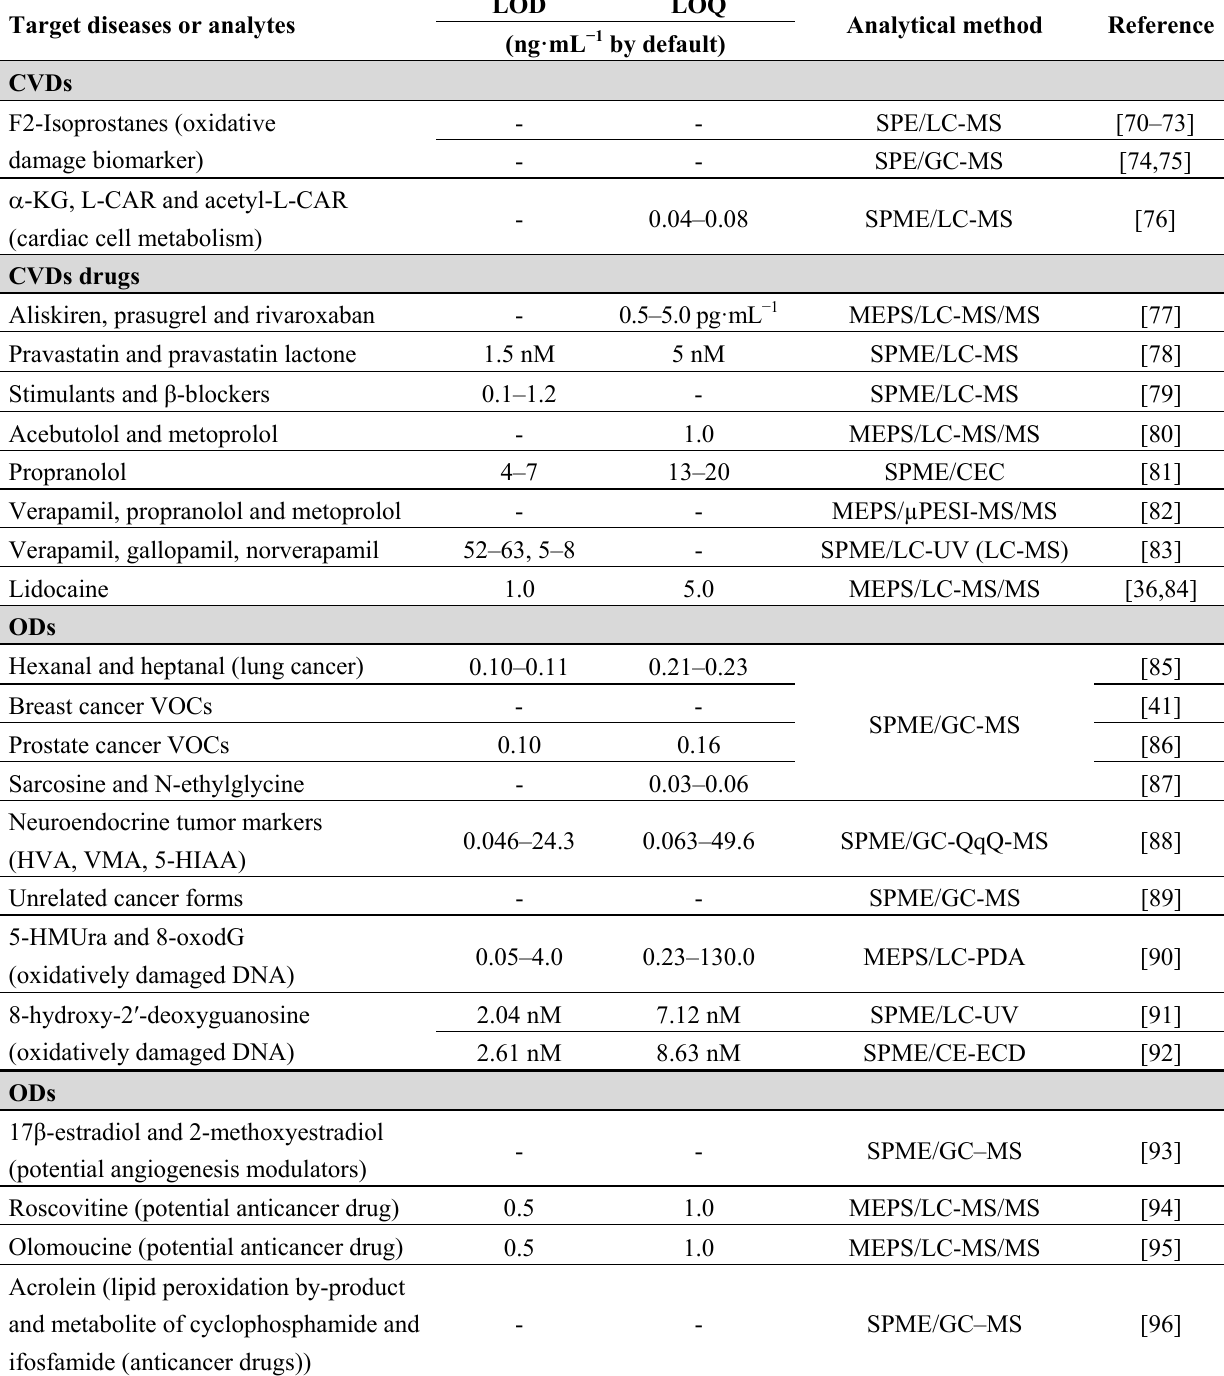
Table 2. Representative reports using MEPS and SPME methodologies in the characterization of target urinary